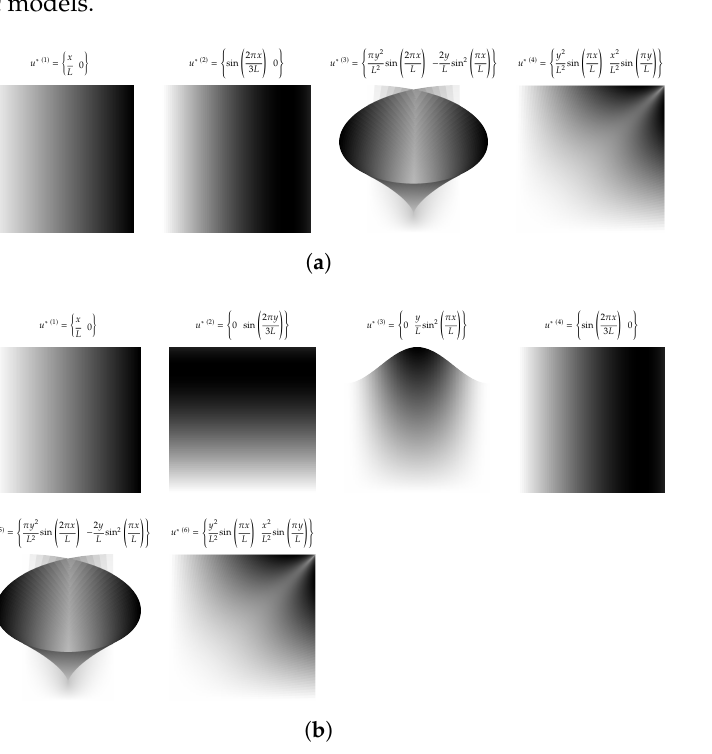
Figure A4. Virtual fields used to train the ( a ) elastic and ( b ) the plastic response